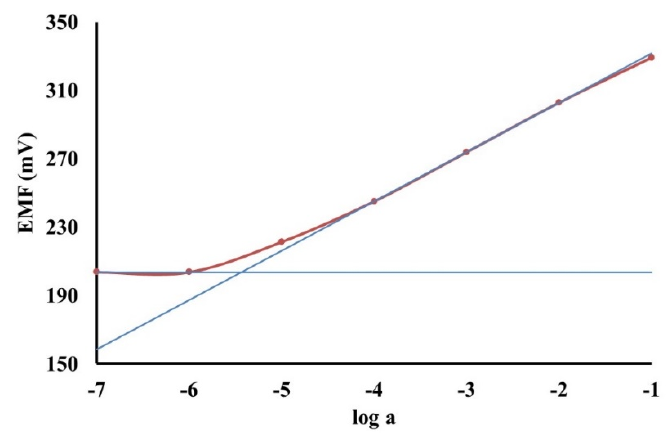
Figure 4. Calibration diagram of the PVC-based electrode membrane containing crown ether ionophore rac - 4 and dioctyl sebacate (DOS) plasticizer with lead(II) acetate. The slope of the calibration curve was 28.9 mV/decade. The ideal operating range of concentration is 10 × 10 −4 to 10 × 10 −2 M, with a detection limit of about 4.0 × 10 −6 . The deviation was below ±0.5 mV.